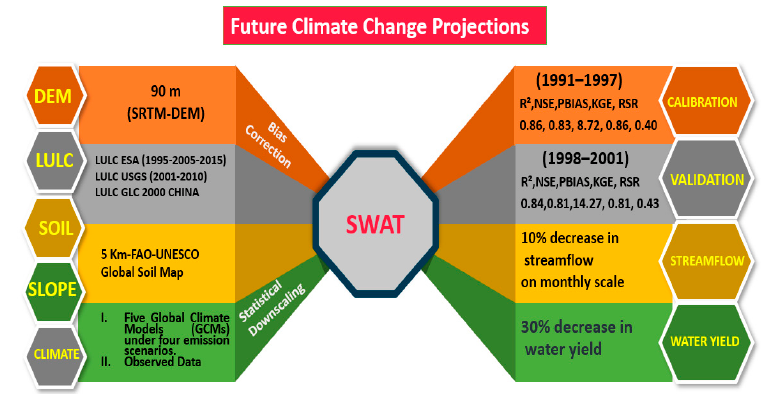
Figure 3. Process of the Soil and Water Assessment Tool (SWAT) hydrological modeling.